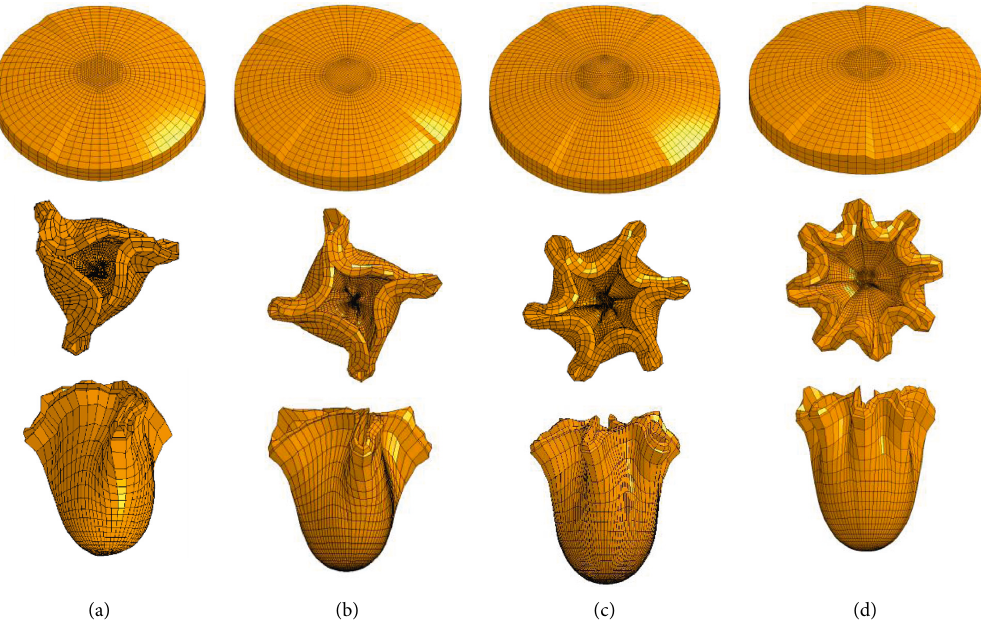
Figure 20: Numerical simulation of EFP formation for four different numbers of steps. (a) a � 3 ( t � 240 μ s, v ( t � 240 μ s, v a � 1401 m/s). (c) a � 6 ( t � 240 μ s, v a � 1400m/s). (d) a � 8 ( t � 240 μ s, v a � 1399m/s).